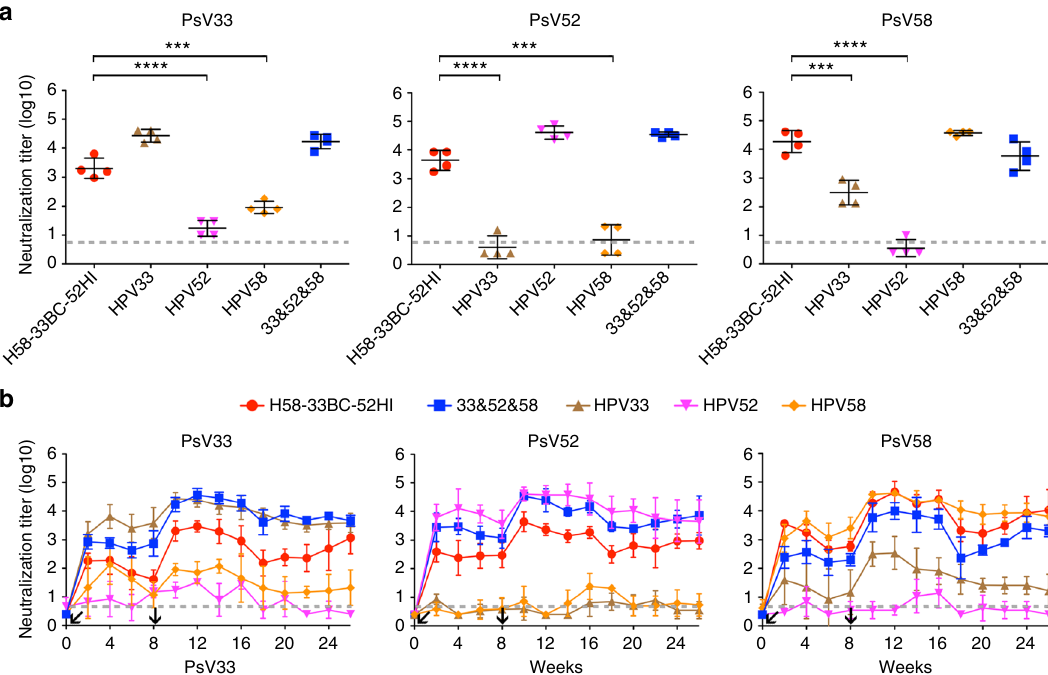
Fig. 6 Immunogenicity of triple-type chimeric HPV33/52/58 VLPs in Cynomolgus Macaques. a Neutralization titers against PsV33, PsV52 and PsV58, respectively, from the immune sera in monkeys ( n = 4) collected two weeks after the second immunization (immunization at weeks 0 and 8 with 5 μ g per dose of aluminum adjuvant-containing chimeric H58-33BC-52HI or WT VLPs). Each symbol represents one monkey. Statistical signi fi cance was assessed by one-way ANOVA, ** P < 0.01; *** P < 0.001; **** P < 0.0001. b Kinetics of serum neutralization titers in monkeys after immunization with the chimeric or WT VLPs. Immune sera were collected weekly after immunization, and serum neutralization titers were determined and plotted. The dotted line indicates the limit of detection for the assay. Non-neutralizing sera were assigned a value of half of the limit of detection for visualization. All the neutralizing titers were calculated to express the mean value with targeting types were located on the side-chains of K53 H33 , N57 H33 , K59 H33 and K60 H33 for HPV58 vs. HPV33 (Fig. 7c, bottom left), and K380 H52 , S383 H52 and E388 H52 for HPV58 vs. HPV52 (Fig. 7d, bottom left). By loop swapping with a few aa mutations on HPV58 L1 — i.e., S80N, N82T, N84A and V87L for BC loop, T375K, G378S and D383E for HI loop (Fig. 7a) — the